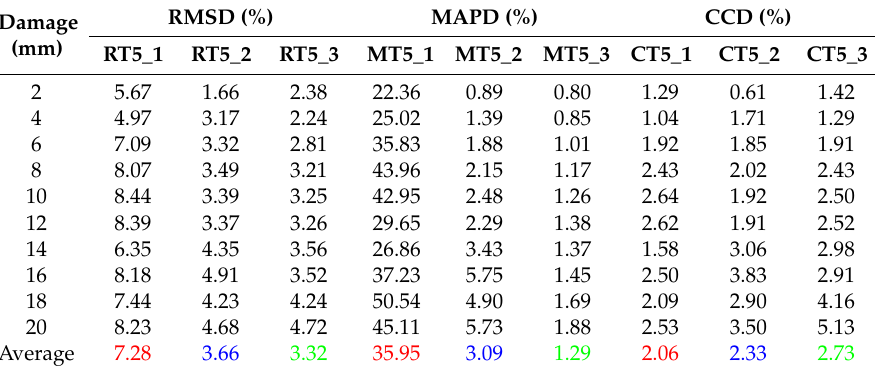
Table 4. Three statistical metric values for the T5_1, T5_2 and T5_3